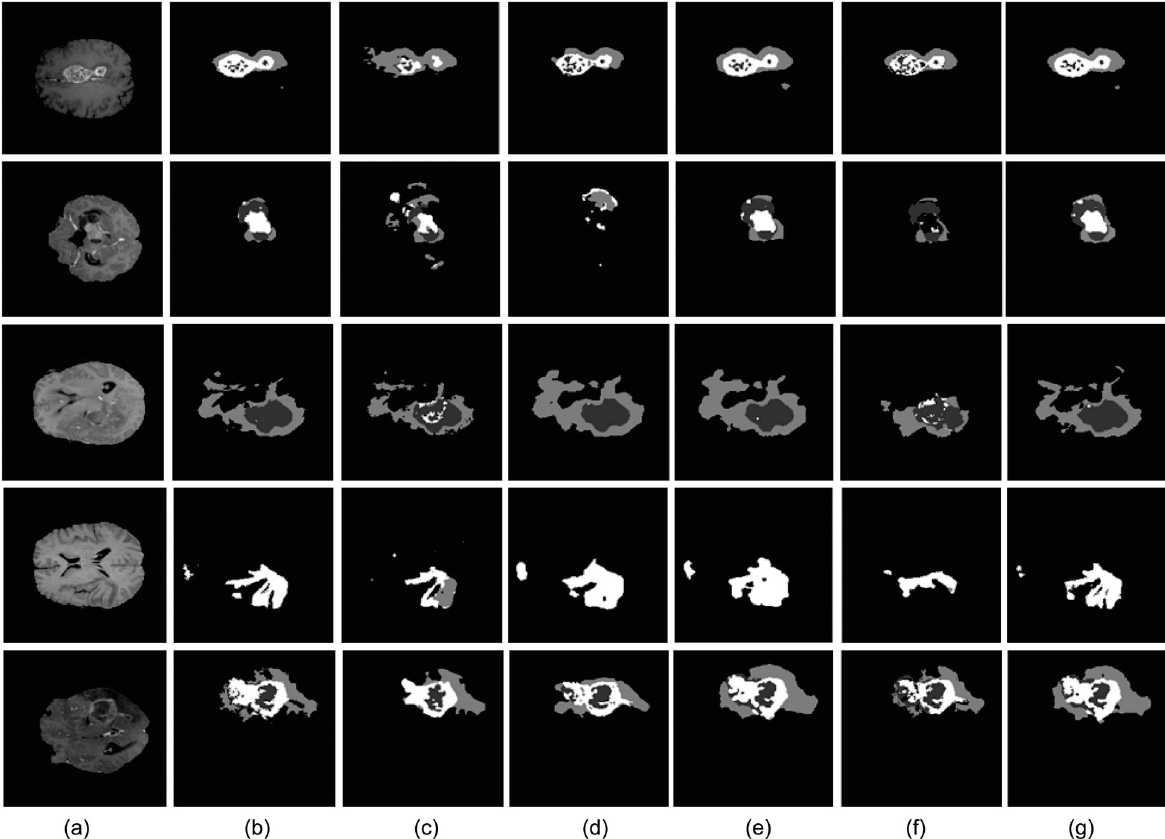
Fig. 6 Segmentation results of SegNet models and SegNet DT method. (a)–(g) MRI slices, ground truth, SegNet1 Flair, SegNet2 T1, SegNet3 T1ce, SegNet4 T2, and SegNet Max DT,